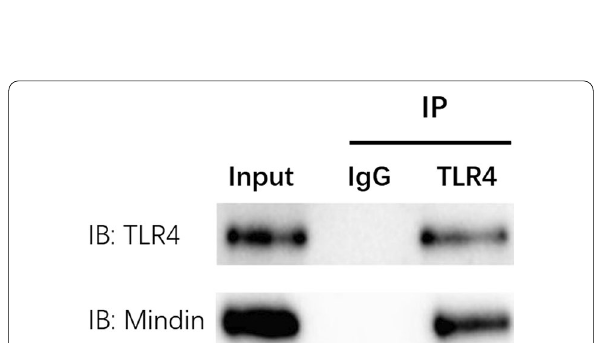
Fig. 9 Co-immunoprecipitation of TLR4 and mindin in HK-2 cells. Lysates of HK-2 cells were incubated with anti-TLR4 antibody and immune complexes were precipitated by protein A/G beads. The TLR4 complex was determined TLR4 and mindin proteins in the complex. The whole cell lysate was used to detect TLR4 and mindin by Western blot